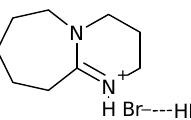
Figure 8. DES based on [DBUH][Br] and HBD.